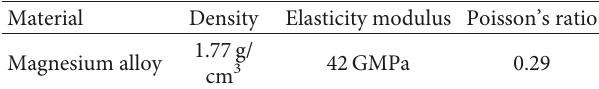
Figure 4: Finite element model. Table 3: Mechanical properties of magnesium alloys.